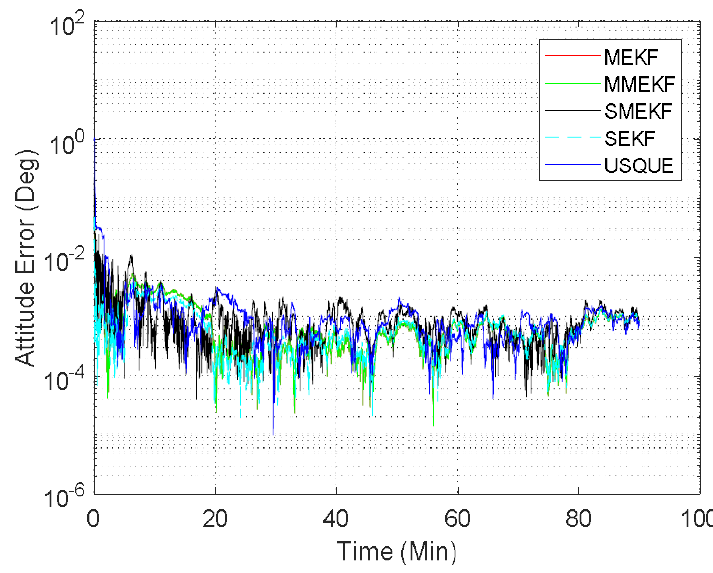
Figure 2. Norm of attitude estimation errors (case 1).